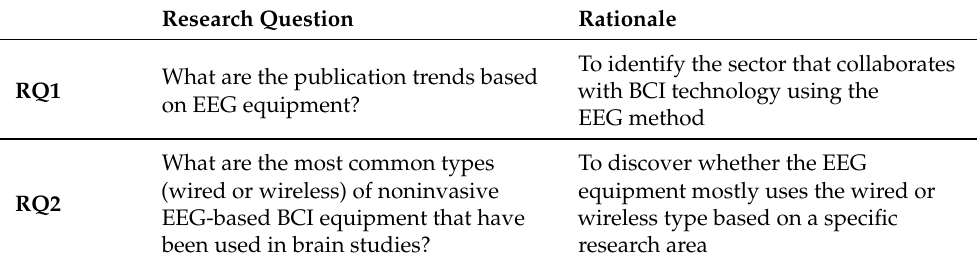
Table 1. SLR research